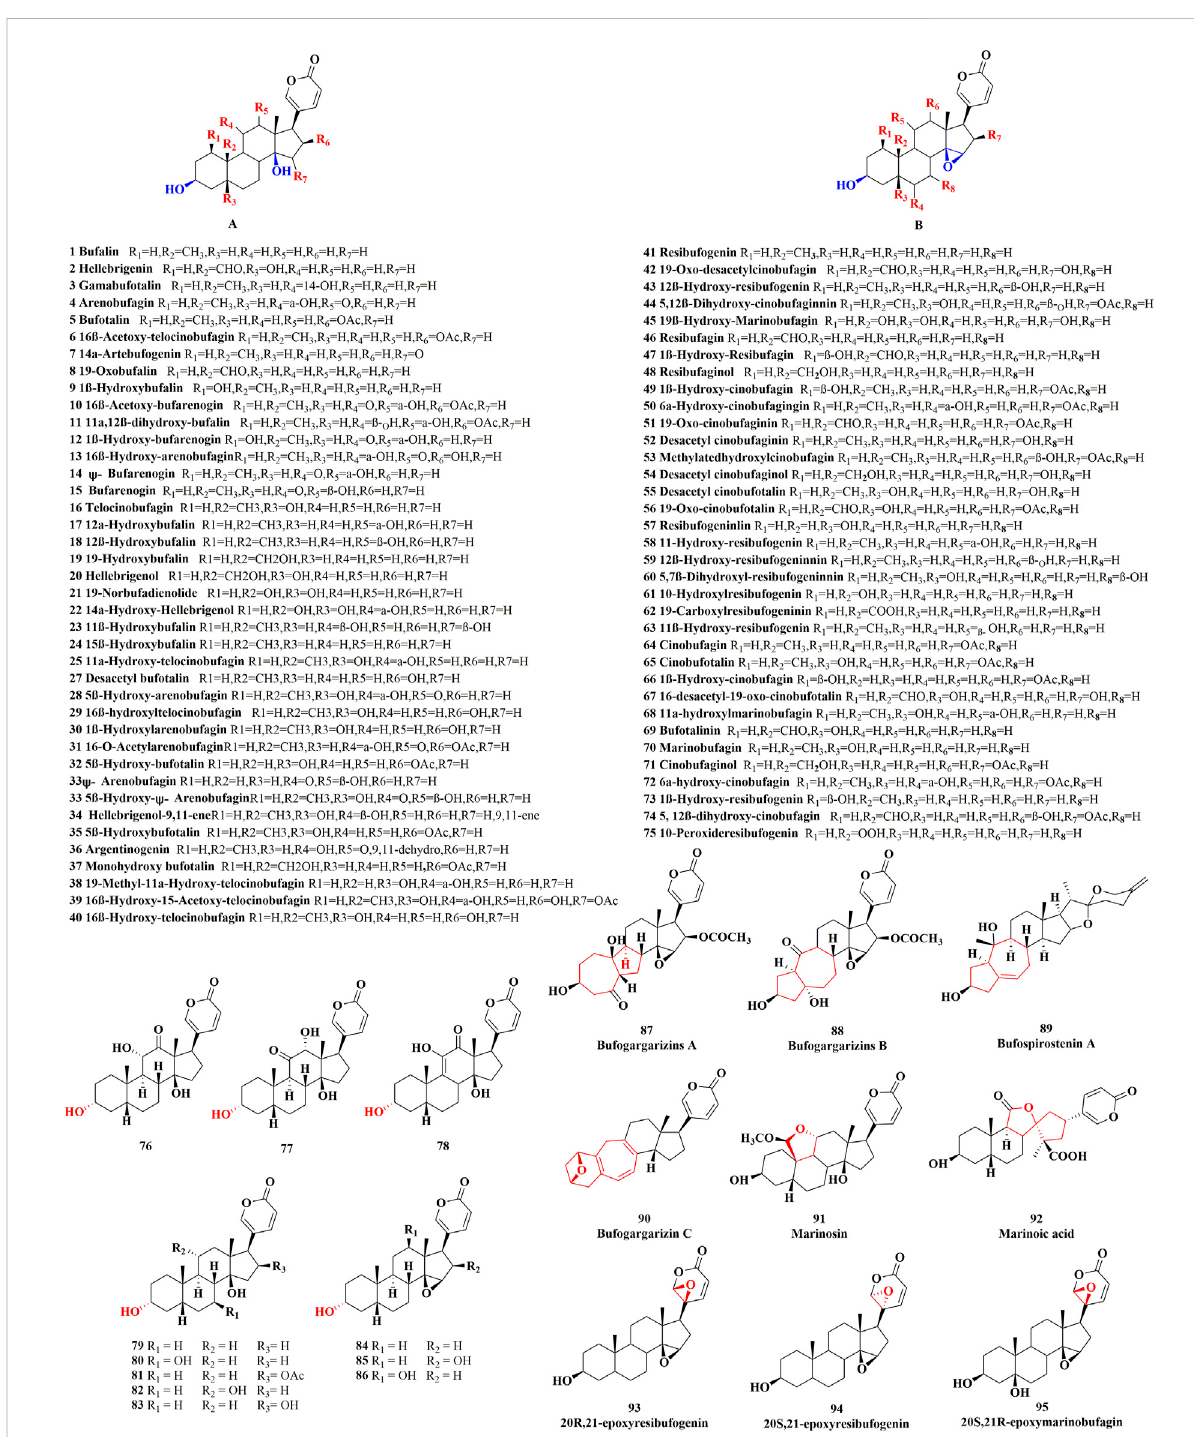
FIGURE 2 The chemical structures of reported free